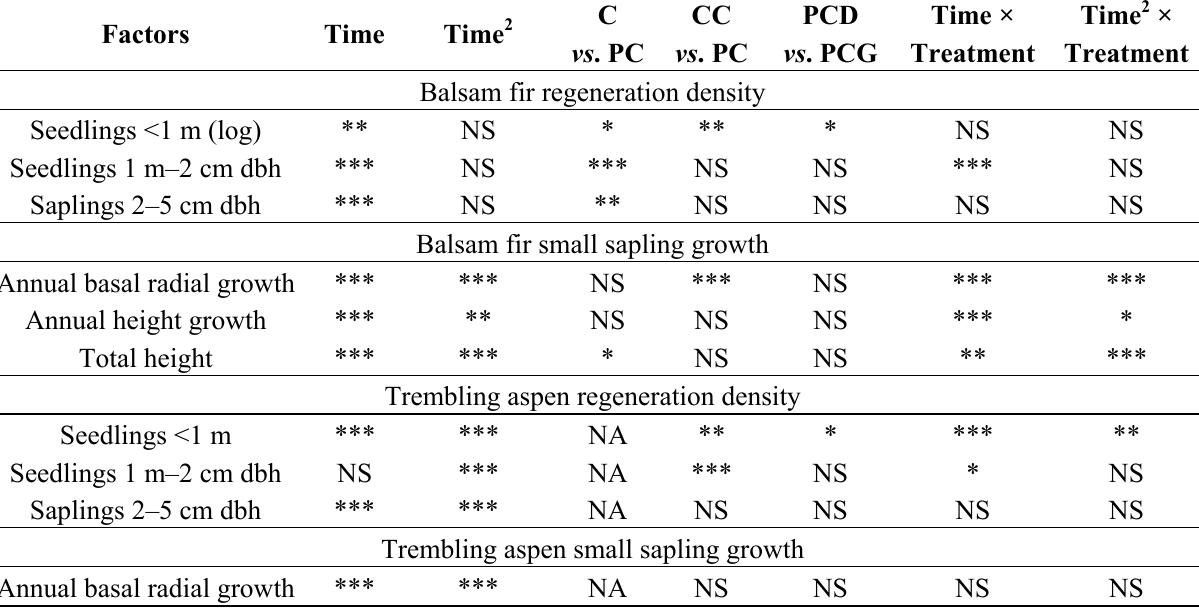
Table 2. Effects of harvesting and time since harvesting on balsam fir and trembling aspen regeneration density and growth in mixed boreal. Significance of fixed effects is based on the Type 1 test of